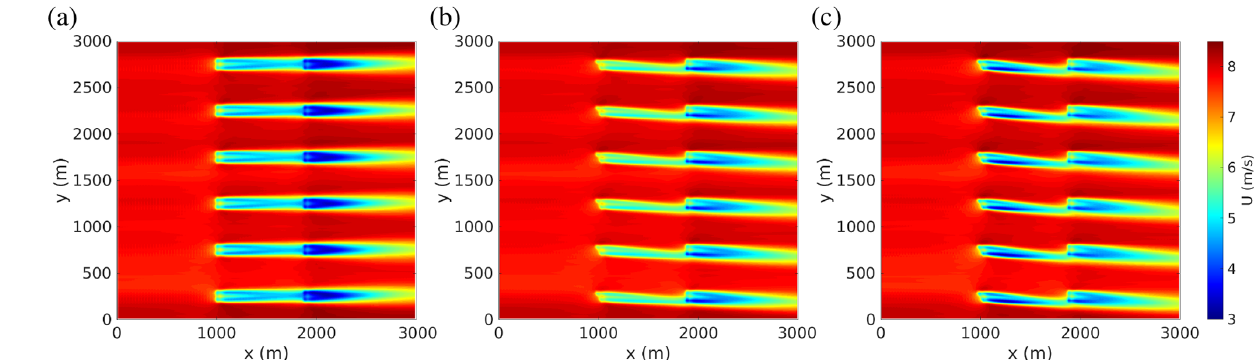
Figure 6. Yaw control: mean streamwise velocity field in the horizontal plane at hub height obtained (a) in the baseline case, where all turbines are operated in default mode ( γ = 0 ◦ , β = 0 ◦ ; same as Fig. 2a, reproduced here to ease the comparison); (b) in the case with upwind turbines yawed by γ = 30 ◦ and operated at the default β = 0 ◦ ; and (c) with upwind turbines yawed by γ = 30 ◦ and operated at higher induction ( β = − 4 ◦ ).